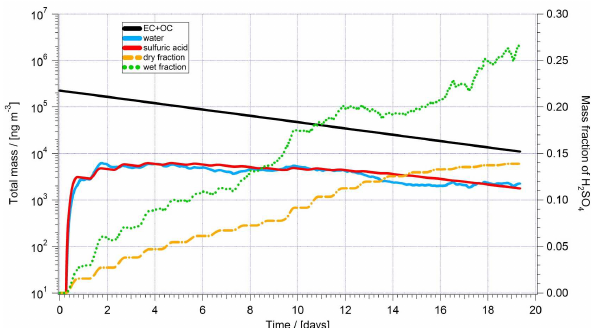
Fig. 11. Time sequence of the modeled mass concentrations of the primary smoke particle components (EC+OC), and the secondary components H 2 SO 4 and H 2 O (left axis). Time sequence of the modeled H 2 SO 4 wet and dry mass fraction of smoke particles (right